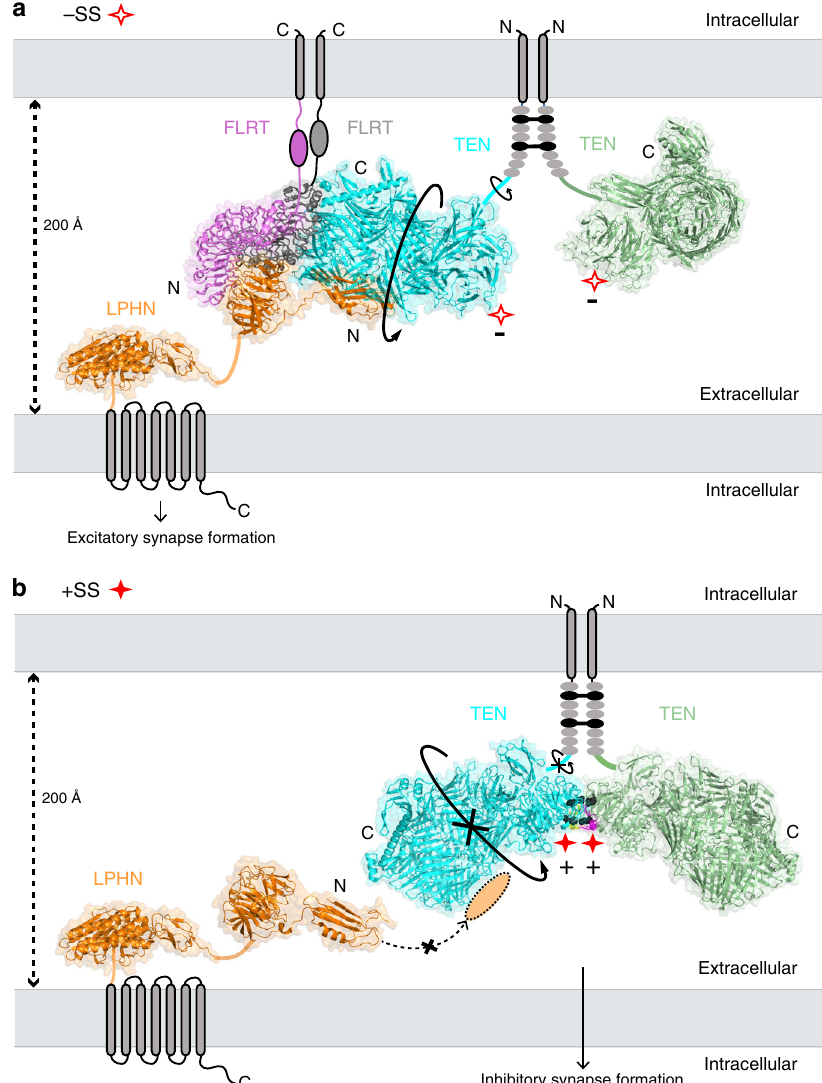
Fig. 9 Model for the splice variant-dependent interaction of TEN2 with LPHN3. The model depicts how alternative splicing acts as a molecular switch to determine which adhesion partner TEN2 binds to and, accordingly, which type of synapse TEN2 speci fi es. Both TEN2 isoforms form a cis-dimer on the presynaptic membrane through two disul fi de bonds formed between the 2nd and 5th EGF repeats (black sticks). a TEN2 − SS isoform has rotational fl exibility (arrows) that enables TEN2 to fi nd the correct docking geometry in order to bind to the Lec domain of LPHN3 expressed on the neighbor cell 2 . Such rotational fl exibility also allows FLRT3 to bind to the Olf domain of LPHN3 and, altogether, to induce excitatory synapse formation. The DHR mutation breaks the interaction of TEN2 − SS with LPHN3 and abolishes excitatory synapse formation. b The TEN2 + SS isoform does not have rotational fl exibility around the linker between the EGF repeats and the rest of the extracellular head as observed in the crystal structure of the TEN2 + SS isoform, which shows that the splice insert mediates a dimeric interaction between the two TEN2 + SS protomers 38 (Fig. 8a, PDB ID: 6FB3). Instead, the TEN2 + SS protomers are zipped-up due to the additional two salt bridges (black balls) between the propellers of the TEN2 cis-dimer. Thus, the LPHN-binding site on TEN2 + SS is not at the right docking geometry to interact with the Lec domain of LPHN3 expressed on the neighboring cell (though it can still bind soluble Lec domain). The geometry of TEN2 + SS likely enables other hetero- or homophilic protein interactions that were not possible in the − SS isoform, such as TEN2 trans- homodimerization, and mediates inhibitory synapse formation. The DHR mutation on TEN2 + SS has no effect on these unknown interactions and thus, does not affect the ability of TEN2 + SS to induce inhibitory synapses. Model partially drawn to scale. The LPHN ECR structure (orange), is based on Lec and Olf domain structure (PDB: 5AFB), connected by a STP-rich stalk to the GAIN and HormR domain structure (PDB: 4DLQ). TEN2 protomers are colored as cyan and palegreen (PDB: 6CMX and 6FB3), FLRT protomers are colored as magenta and gray (PDB: imidazole, the biotinylated lectin was eluted with HBS buffer containing 200 mM puri fi ed in a fi nal buffer comprised of 10 mM Tris pH 8.5, 150mM NaCl. For the fl ow cytometry binding assays, LPHN1 Lec (residues S26-Y131) and LPHN3 Lec imidazole. Puri fi ed protein was applied to size-exclusion chromatography. The ef fi ciency of biotinylation was assessed using a streptavidin bead pulldown assay. (residues S21-Y126) were cloned with carboxyl-terminal 6XHis-AVI-tags and captured on nickel-nitrilotriacetic resin as described above. Following a wash with HBS buffer containing 20 mM imidazole, fi nal concentrations of 50mM Bicine pH Cloning and expression in mammalian cells . Full-length TEN2 (residues M1- 8.3, 100 mM NaCl, 10 mM Mg-acetate, 10mM ATP, 0.5mM biotin and 5mM R2648) construct and TEN2 mutants (DHR mutant: D1737N, H1738T, R1739T; BirA were added to the resin, which was then rotated for 2h at 27°C. After LR mutant: L1990N, R1992T) bearing HA-tag (inserted between K405/E406) and removing residual BirA and ATP by washing with HBS buffer containing 20 mM